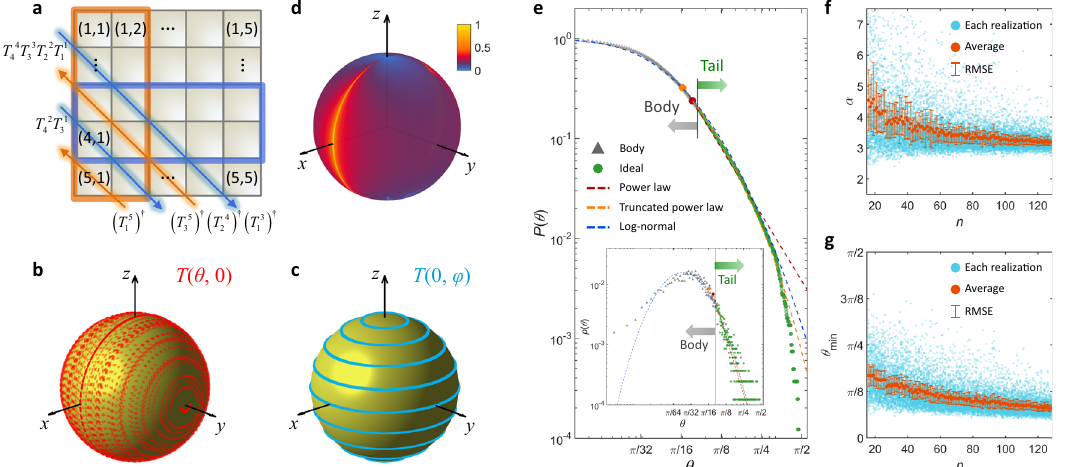
Fig. 2 | Heavy-tailed distributions in unitary photonic circuits. a, b Two origins oftheheavy-taileddistributionsoftherotationoperators:unequaltransformations in the nulling process ( a ) and nonuniform SU(2) rotations ( b – d ). a An example of the nulling process for U 5 . Orange and green arrows denote the nulling of the off- diagonal elements with UT † and TU , respectively. Red and blue boxes indicate the rotatingcomponentsforthenullingofthe(5,1)and(4,1)components,respectively. Rotated states with T ( θ , 0)( b ), T (0, φ ) ( c ),and T ( θ , φ ) ( d ).Each point in ( b ) and ( c ) denotes the transformed state through the corresponding T applied to the uni- formlyrandominitialstateson the Blochsphere. The colorsinthe mapin d depict the nonuniform density of the transformed states on the Bloch sphere. The initial states in ( b ) and ( c ) are obtained with 10 polar grids and 20 azimuthal grids (200